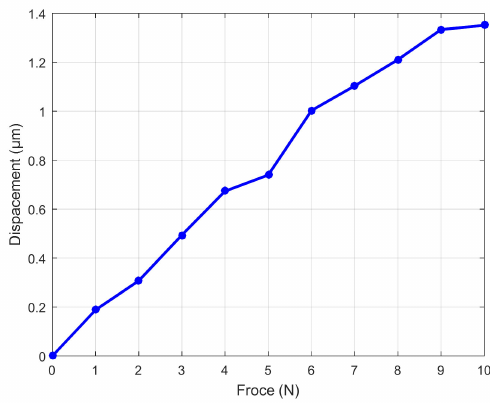
Figure 18. Variation of